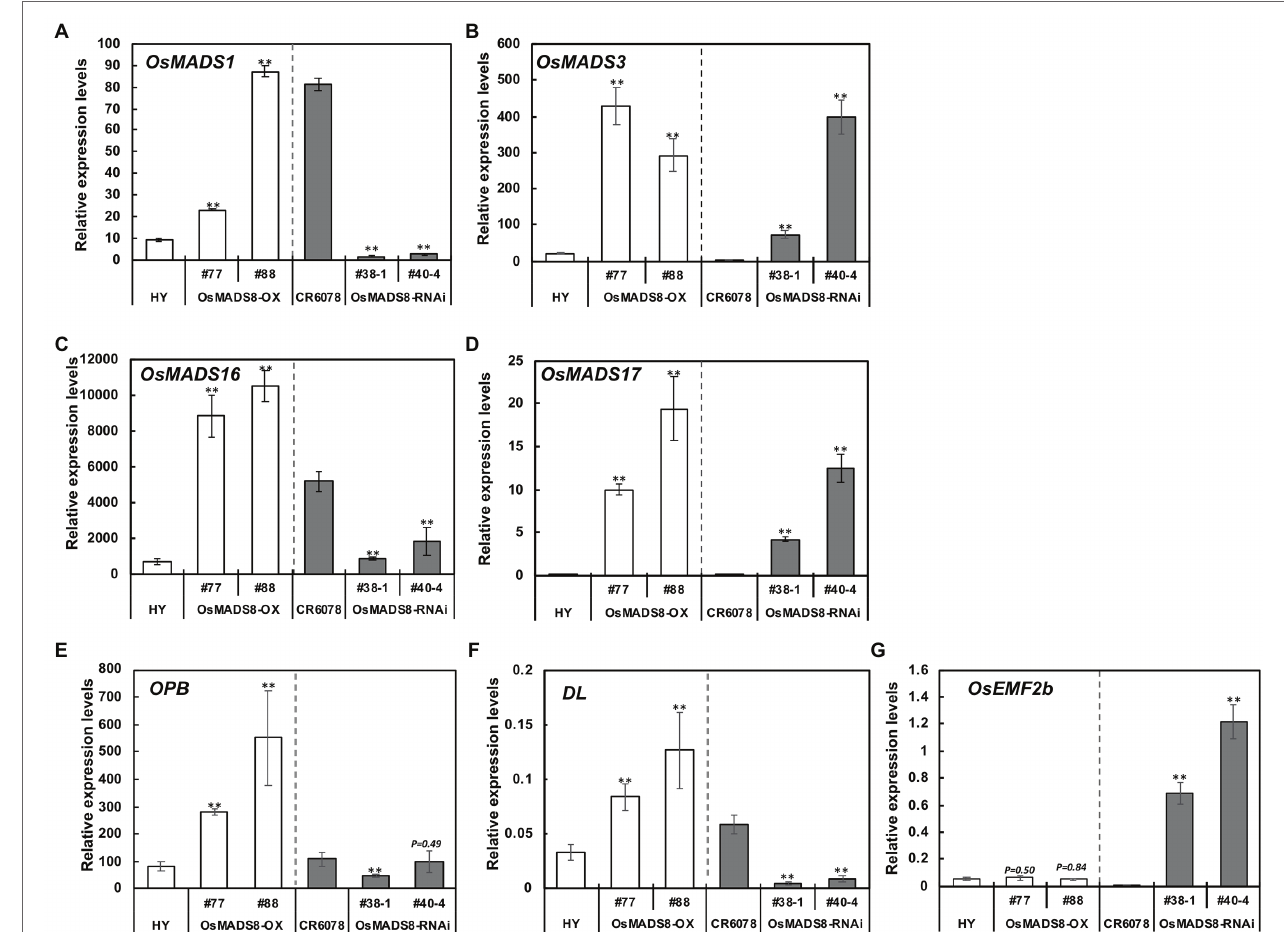
FIGURE 5 | Expression of seven floral development genes in the OsMADS8 transgenic lines. (A) OsMADS1 , (B) OsMADS3 , (C) OsMADS16 , (D) OsMADS17 , (E) OPB , (F) DL , and (G) OsEMF2b . Total RNA was isolated from the 7-day-old seedlings of the OsMADS8 transgenic lines. Relative expression level of each gene was quantified using real-time PCR and normalized using OsTMP1 as an internal control. The error bars represent mean ± SD ( n = 3). The significant differences between the HY and each OX line and the CR6078 plants and each RNAi line were evident at ** p <